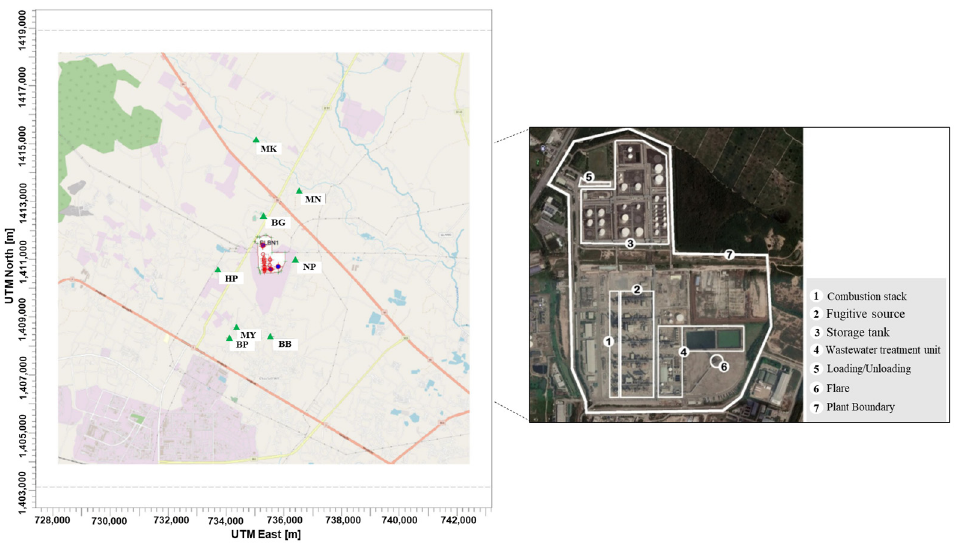
Figure 1 . Locations of VOC emission sources. Figure 1. Locations of VOC emission